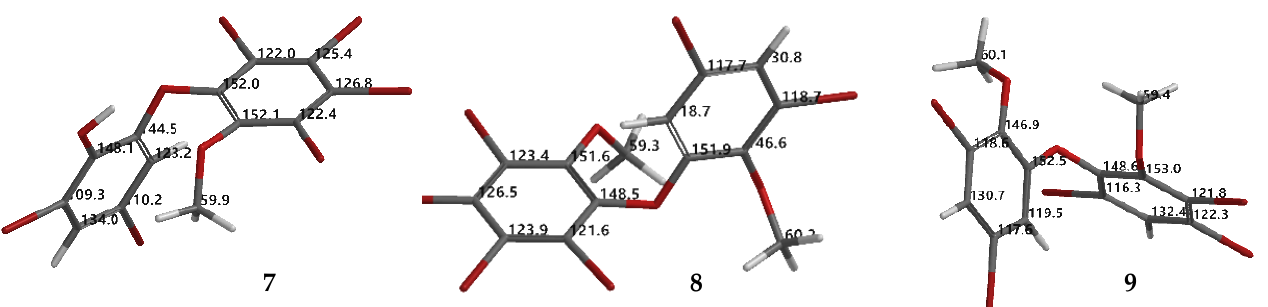
Figure 4. Torsion and dihedral angles of 1 , 8 , and 9 .